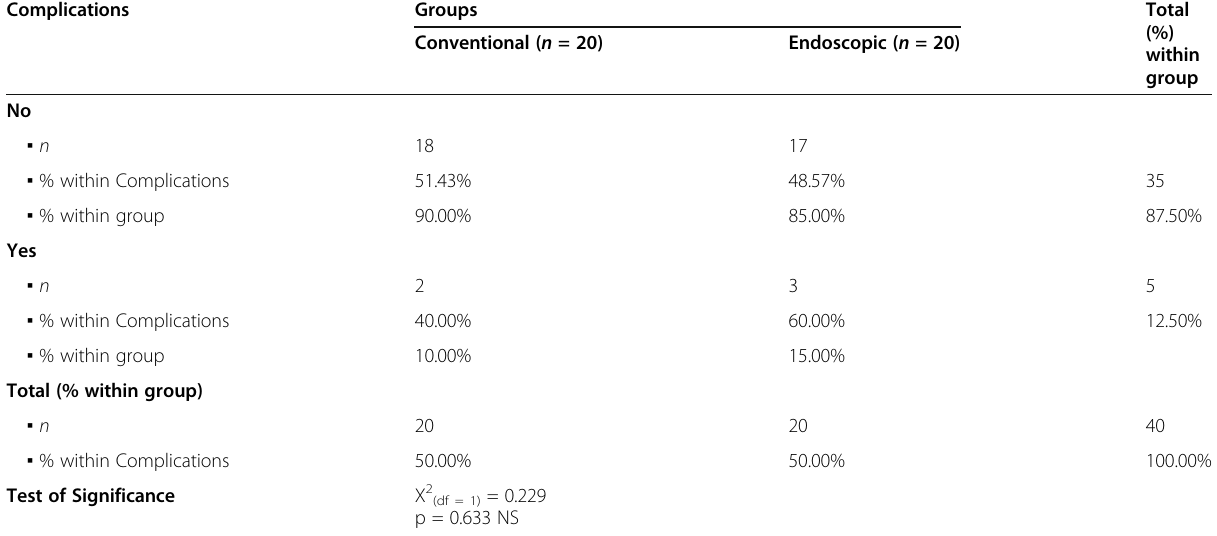
Table 5 The incidence of complications in between the two studied groups. No significant difference was found between the groups. However, the complications in the conventional group were graver than those in the endoscopic group. On the one hand, a case of TM perforation and another of facial nerve paresis occurred in the posterior tympanotomy group. On the other hand, a case of PCW perforation, another case of chorda tympani injury, and a third case of TMF perforation occurred in the endoscopic